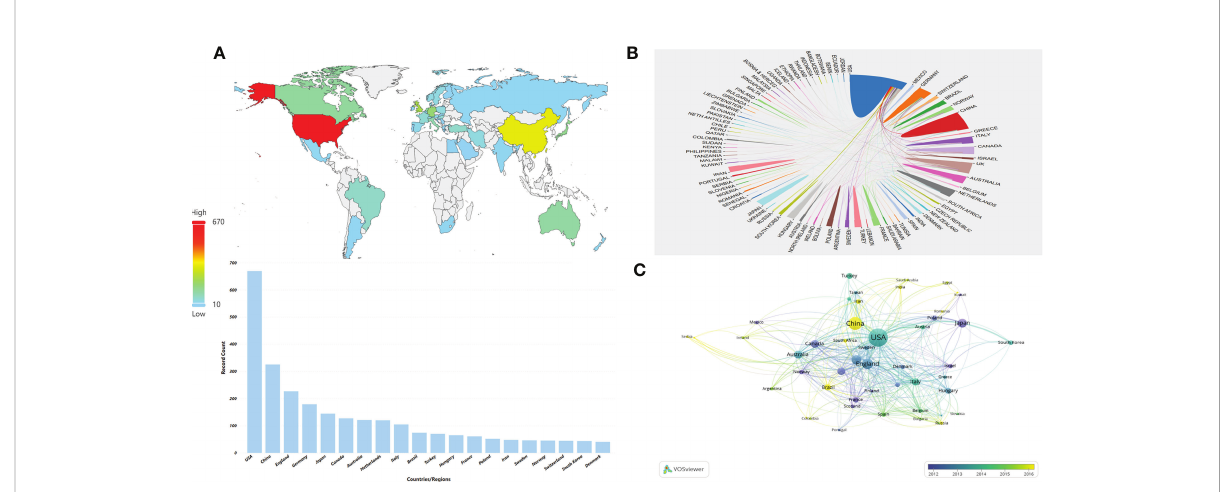
FIGURE 3 Distribution of countries or regions and mutual cooperation relations. (A) Distribution of the top 10 countries/regions in terms of number of publications on the world map. (B) The cooperative network map between countries or regions. The color represents different countries/ regions,the area represents the number of citations in each country or region, and the thickness of the connecting line indicates the cooperation frequency. (C) Overlay visualization of country/region cooperation analysis. The circles indicate different countries/regions, the color represents the average year, the area of the circle represents the number of citations in each country or region, the distance indicates the correlation between each country/region, and the thickness of the connecting line indicates the strength of co-authorship